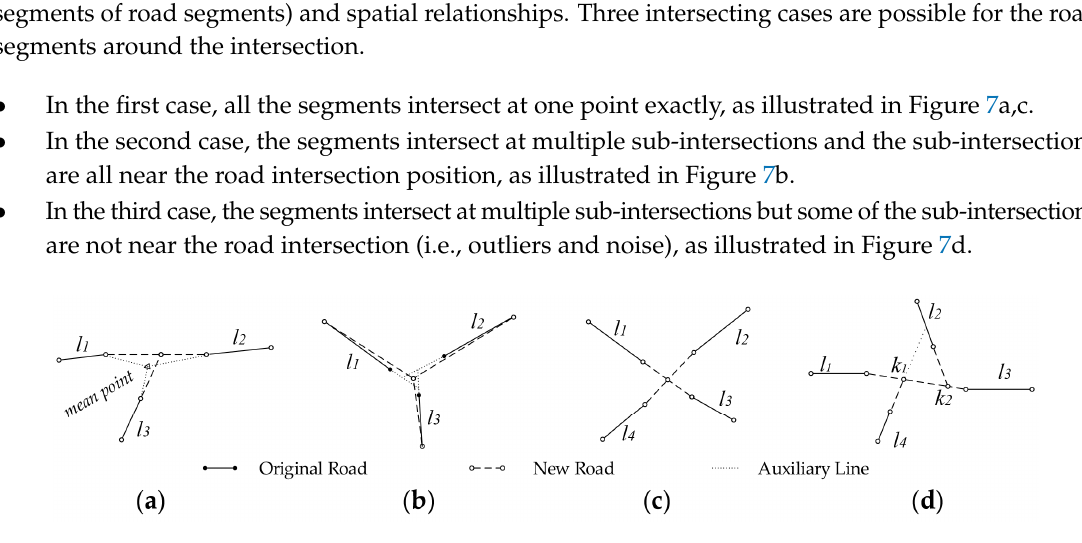
Figure 7. Connecting multiple line segments around an intersection. ( a ) T-intersection detected by the single intersection of segments on two conflicting orientations; ( b ) three-forked road intersected in three conflicting orientations, with an acute small triangle formed by the intersection of the three roads and the centroid of the triangle representing the intersection of the three roads; ( c ) crossroad with two conflicting orientations intersecting at one point; and ( d ) irregular intersection with multiple orientations and multiple sub-intersections.